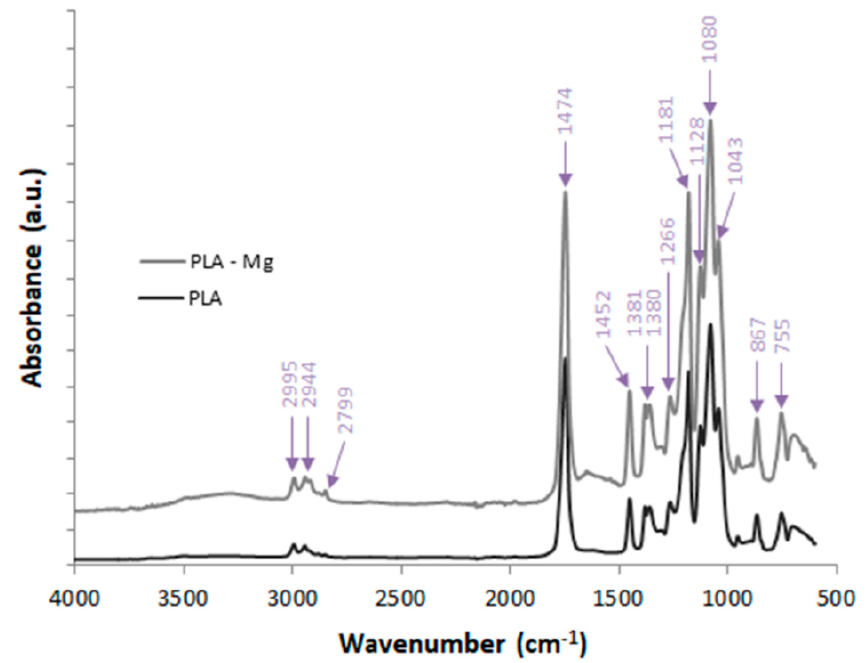
Figure 5. FTIR investigations: PLA, PLA-Mg (Composition 1).